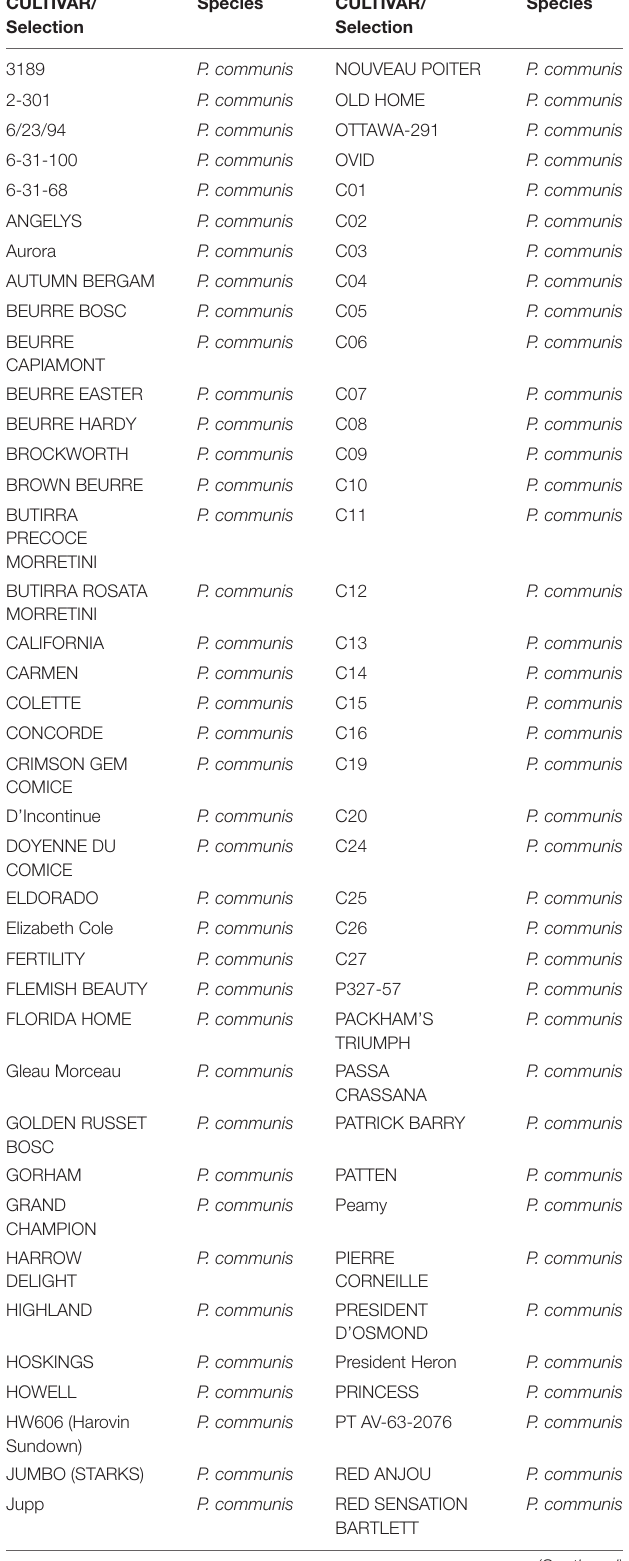
TABLE 1 | List of pear accessions and their Pyrus species group. CULTIVAR/ Selection